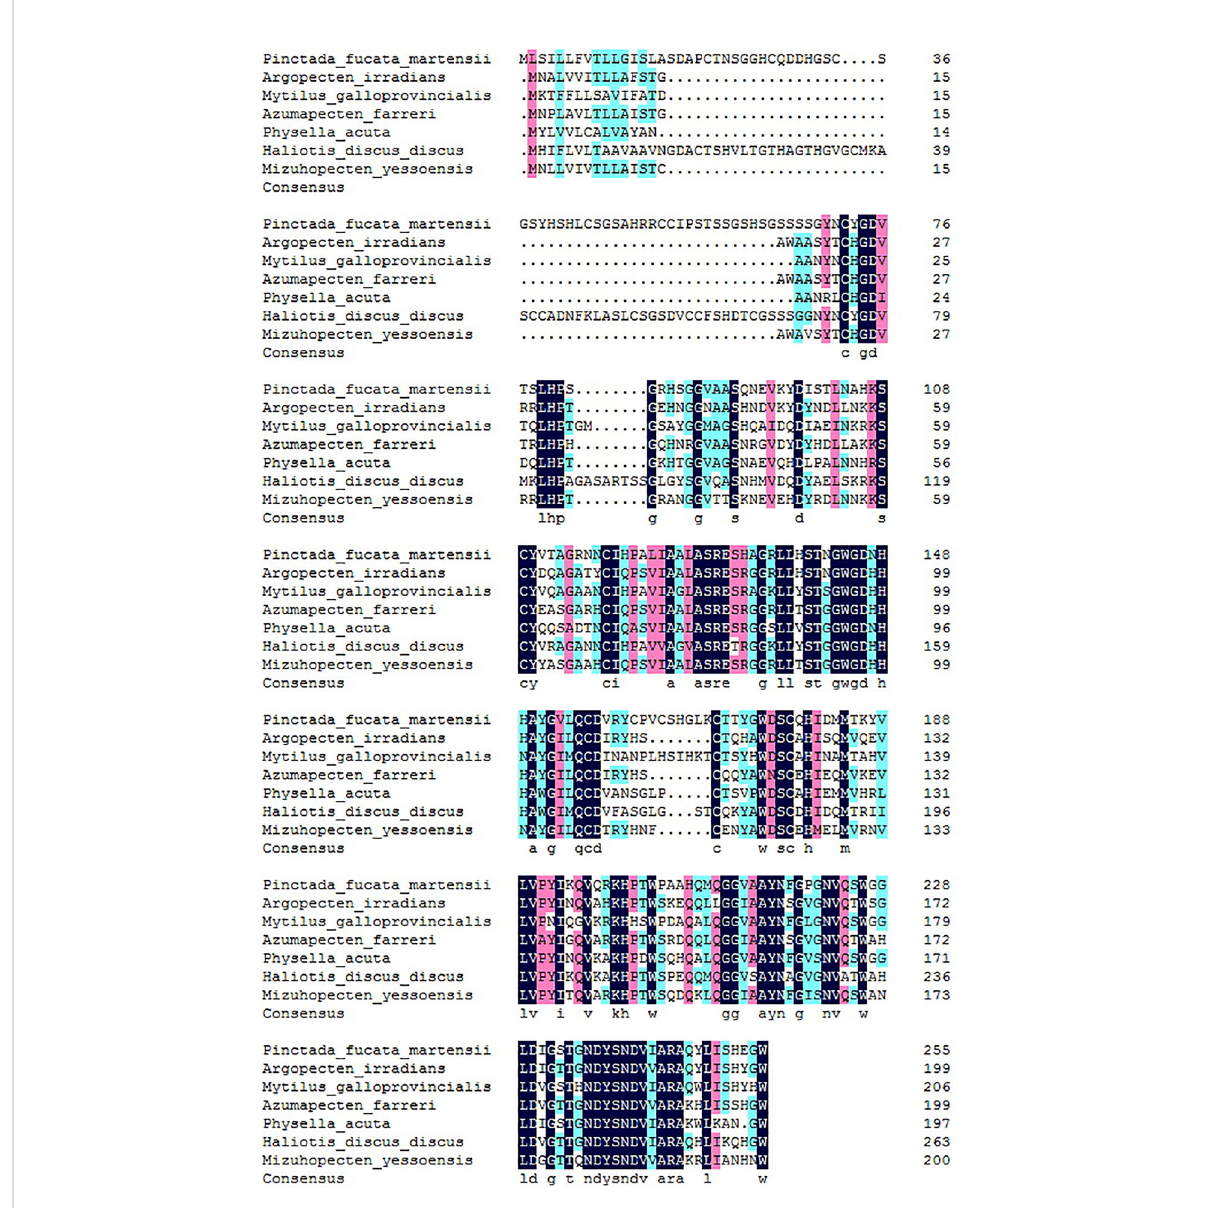
FIGURE 2 PmlysG Homology alignment and the coincident amino acids. Light blue and pink indicate that the similarity is more than 75% and 50%, respectively. Navy blue: Consensus amino